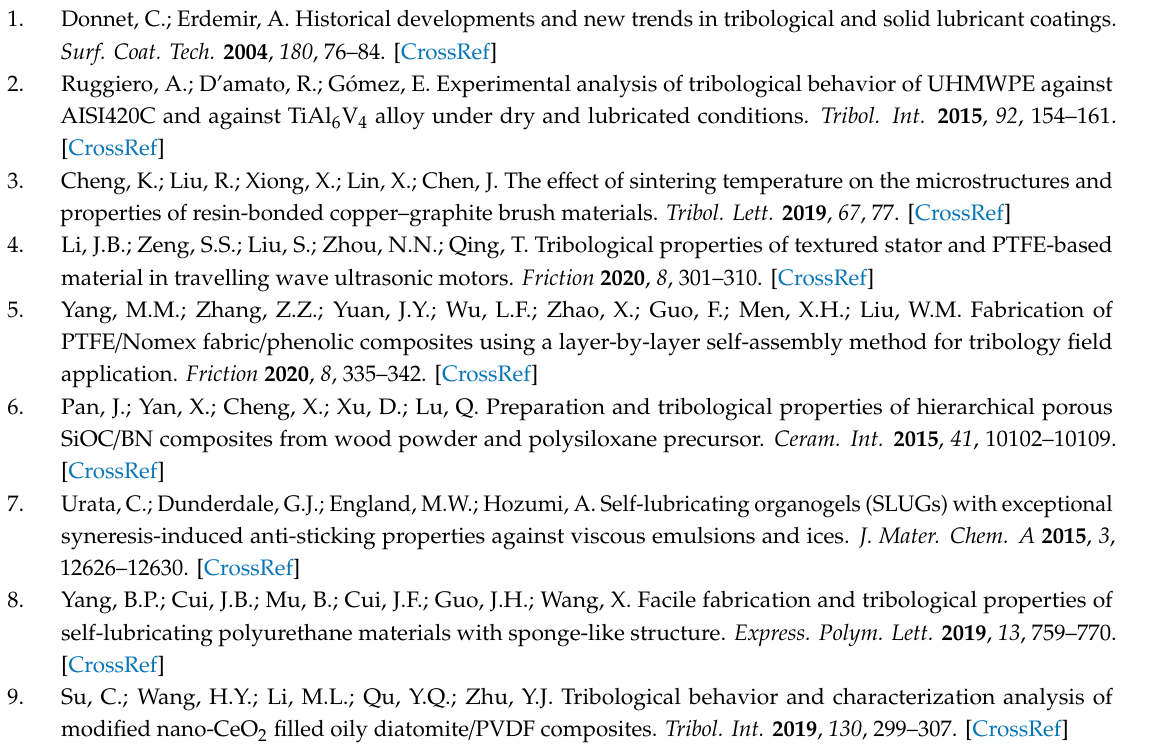
Table S1: The compressive strength (MPa) of the samples under di ff erent process conditions, Table S2: The bending strength (MPa) of the samples under di ff erent process